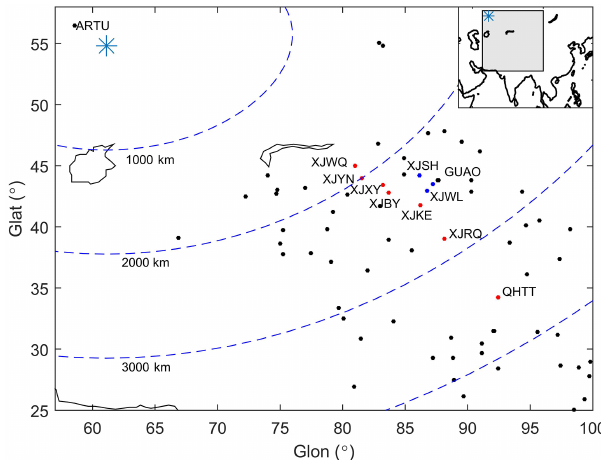
Figure 1. Geometry of the observations. The asterisk marks the location of the meteorite blast site over Chelyabinsk, Russia (54.80 ◦ N, 61.10 ◦ E). The dots represent locations of the GPS sites. Blue curves represent the contours of distances from the meteorite blast site. The distances were calculated based on the arcs on the surface of the Earth. The shaded area in the sub-plot on the upper- right side indicates the location of the observed area in the map of